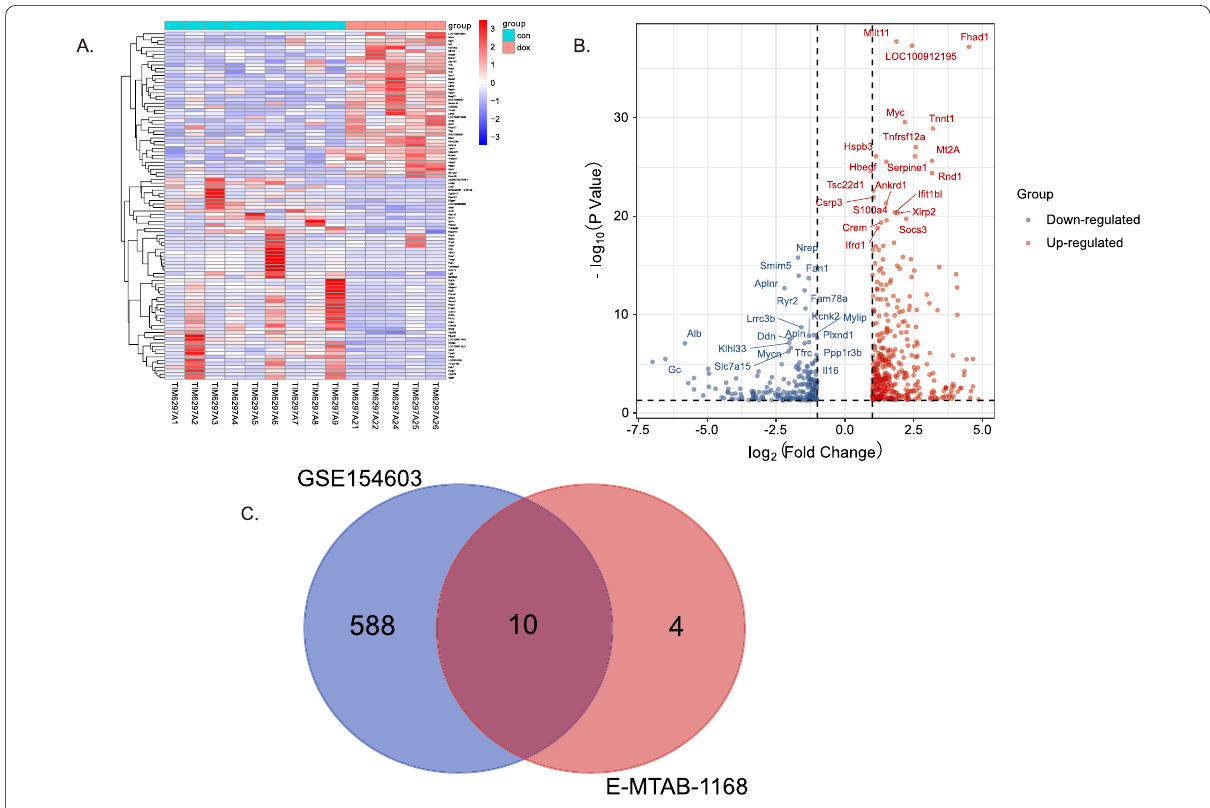
Fig. 5 DEA to verify the 14 core genes. A Heatmap of the DEGs from GSE154603 dataset. B Volcano plot of the DEGs from GSE154603 dataset. C Intersection analysis between DEGs and the 14 core genes for a verification